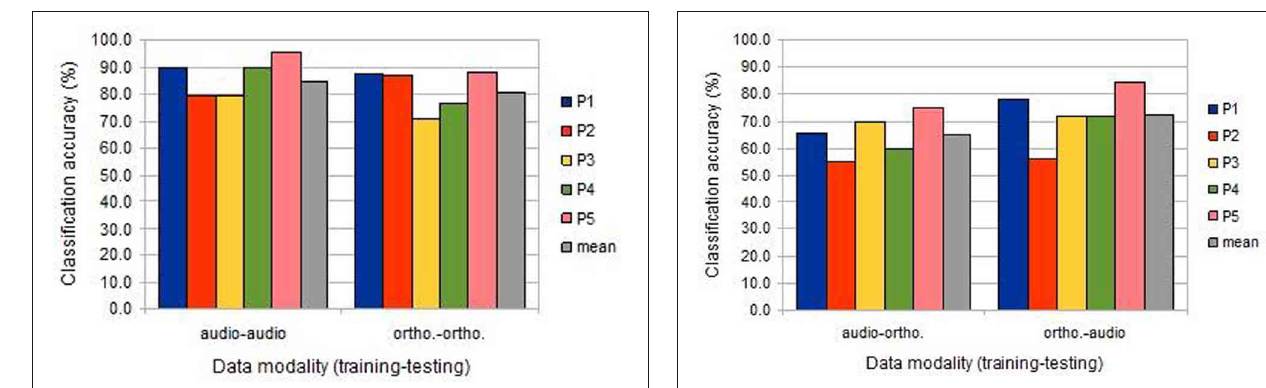
FIGURE 2 | The classification accuracies obtained under the within-session uni-modal conditions from the five participants (BOLD delay = 4; number of volumes = 4).